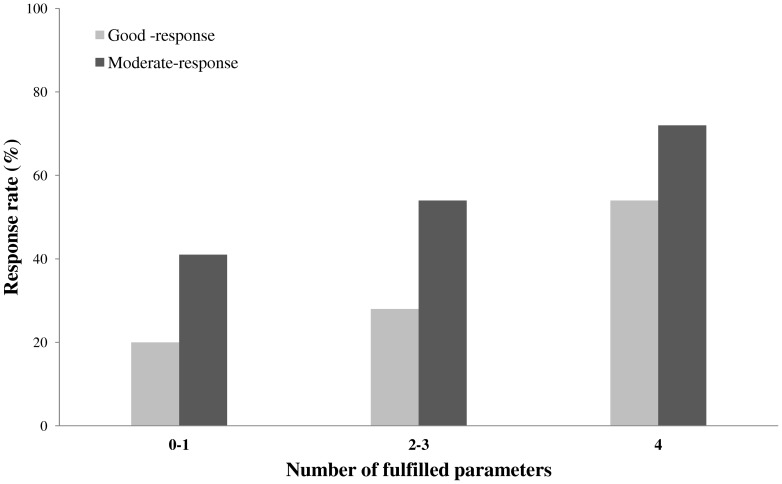
Percentage of good and moderate EULAR response rate (%) in RA patients after 6 months of RTX therapy.Patients were grouped according to the number of fulfilled parameters (corticosteroids therapy, number of circulating lymphocytes <1875/μl, plasma BAFF levels <1011 pg/ml and RF-IgM >52.1 U/ml). Good response was reached in 20.8% of RA patients that fulfilled 0–1 parameter, in 29.2% of subjects that fulfilled 2–3 parameters and in 54.5% of subjects that fulfilled 4 parameters (Fisher's exact test between 4 parameters and 0–3 = 0.08). Moderate-response was reached in 41.7% of RA patients that fulfilled 0–1 parameter, in 54.5% of subjects that fulfilled 2–3 parameters and in 72.7% of subjects that fulfilled 4 parameters (χ2 test = 3.02, df = 2; p = 0.22). *p = 0.046: percentage of good response in patients fulfilling 4 vs 0–1 parameters.